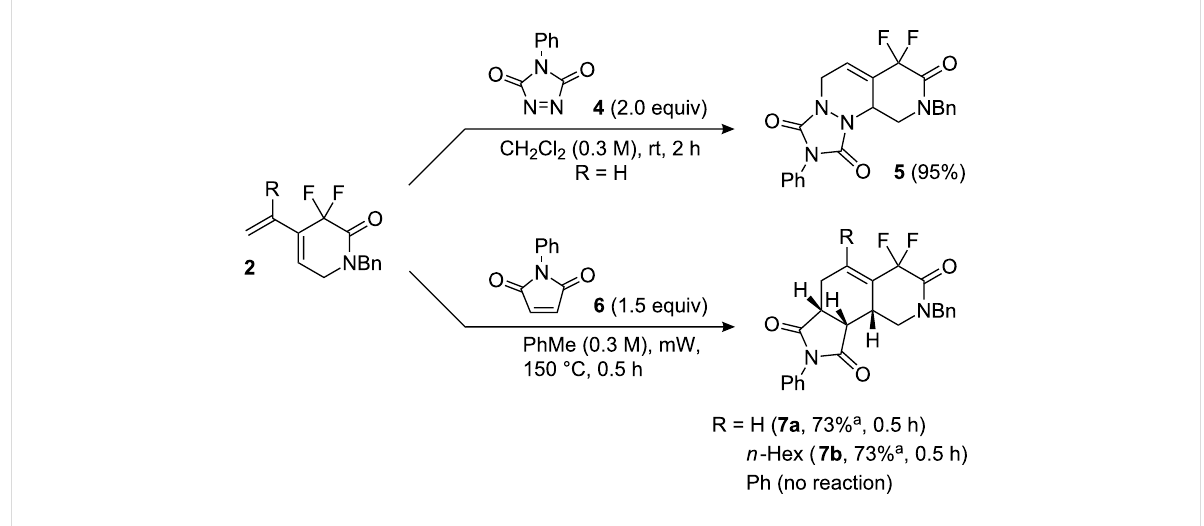
Dienes 2a and 2b were used in Diels–Alder reactions with